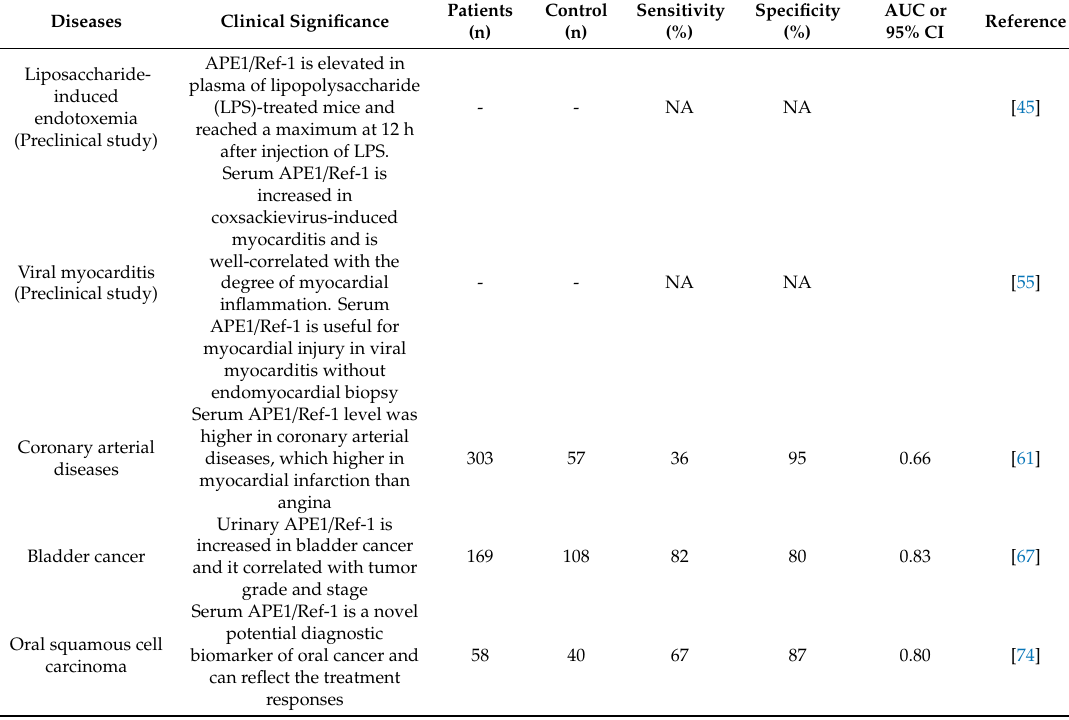
Table 2. Summary of usefulness of APE1 / Ref-1 as potential biomarker in vascular inflammatory disease or